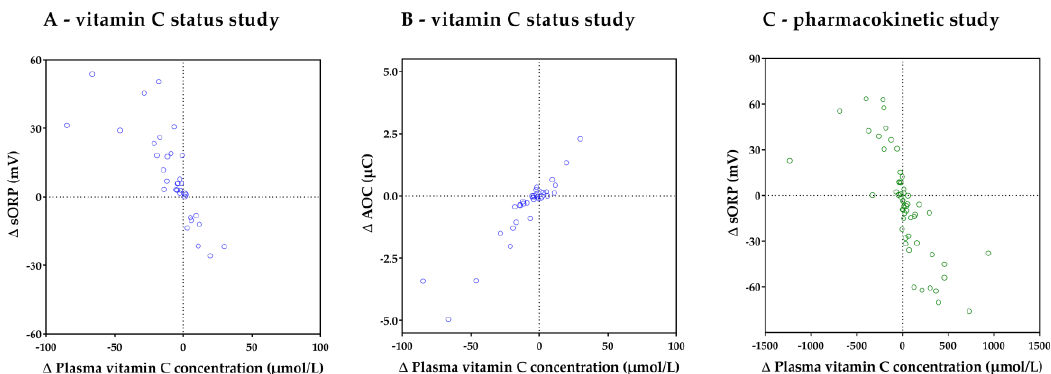
Figure 6. Four-quadrant plots demonstrating the concordance between the changes in plasma vitamin C concentration and changes in sORP and AOC between day 1 and day 3 in the vitamin C status study ( A and B respectively), and changes in sORP per day in the pharmacokinetic study ( C